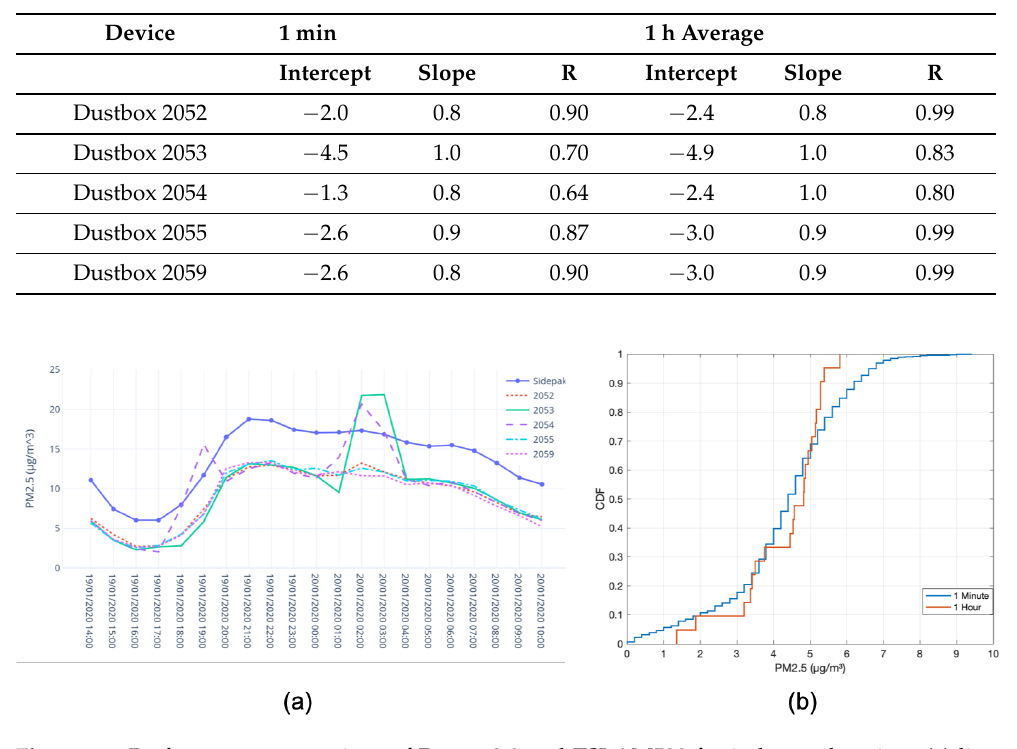
Table 4. Linear regression parameters and measure of linear correlation (R) between PM2.5 concentration ( µ g/m 3 ) of TSI AM520 and five Dustboxes at 1 min and 1 h time intervals during indoor colocation.